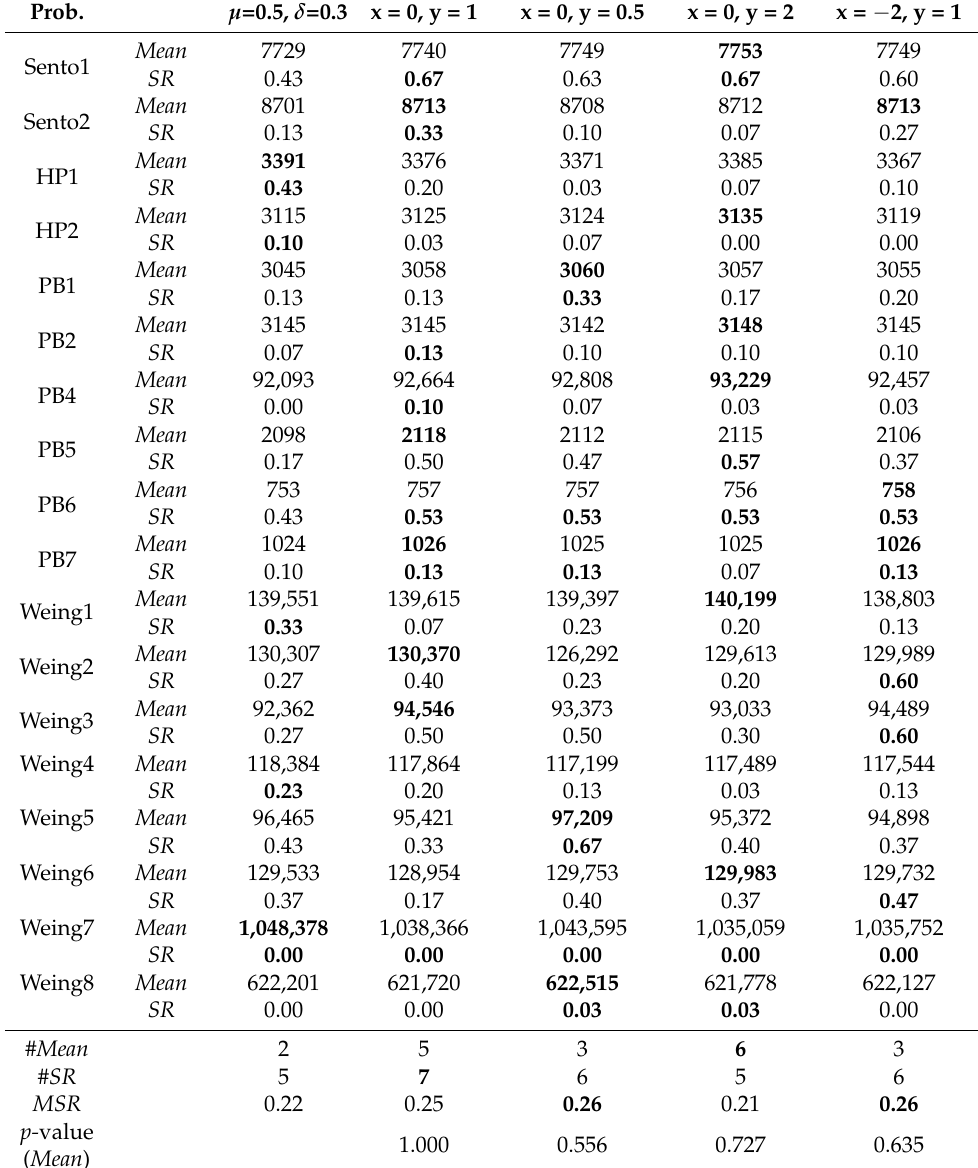
Table 7. The results of HLMS using different parameters of two distributions for Test set I.